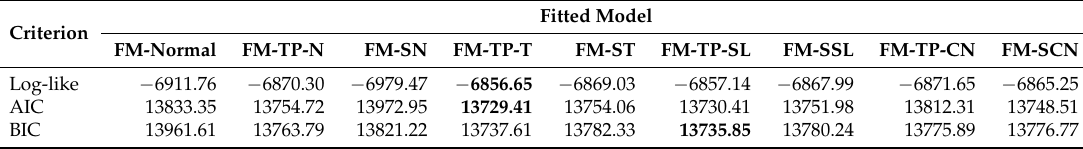
Table 7. Model selection criteria for fitting FM-TP-SMN and FM-scale mixtures of the skew normal (SMSN) models to the BMI data. The best values are marked in bold.